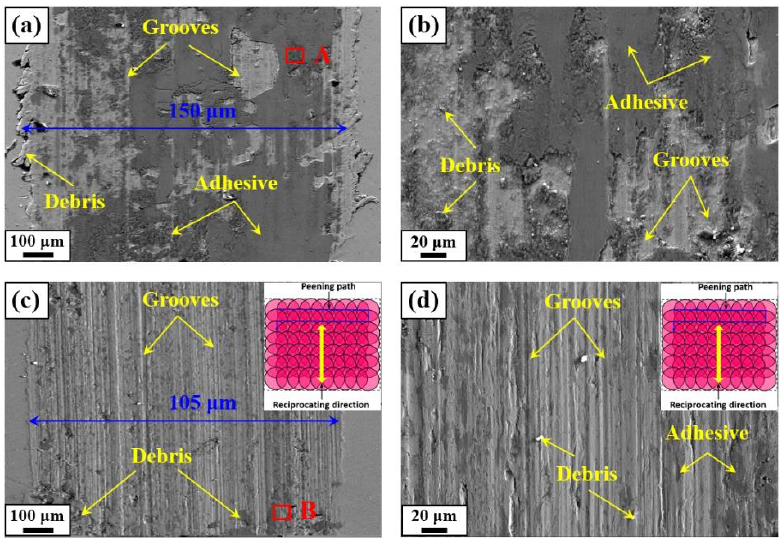
Figure 12. Worn micrographs on the surface of the differently processed samples. ( a , b ) untreated sample, ( c , d ) LSP sample.